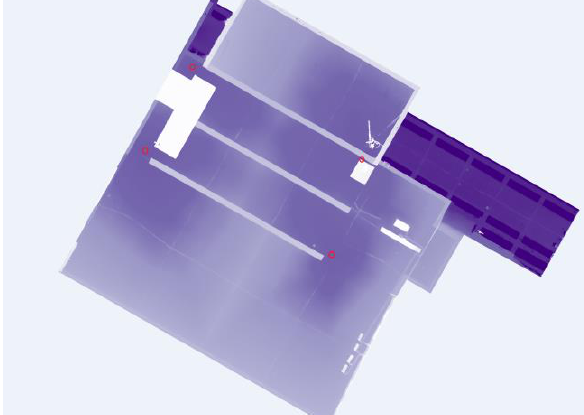
Figure 2 . Visualization of roof slope with red marks of outfall